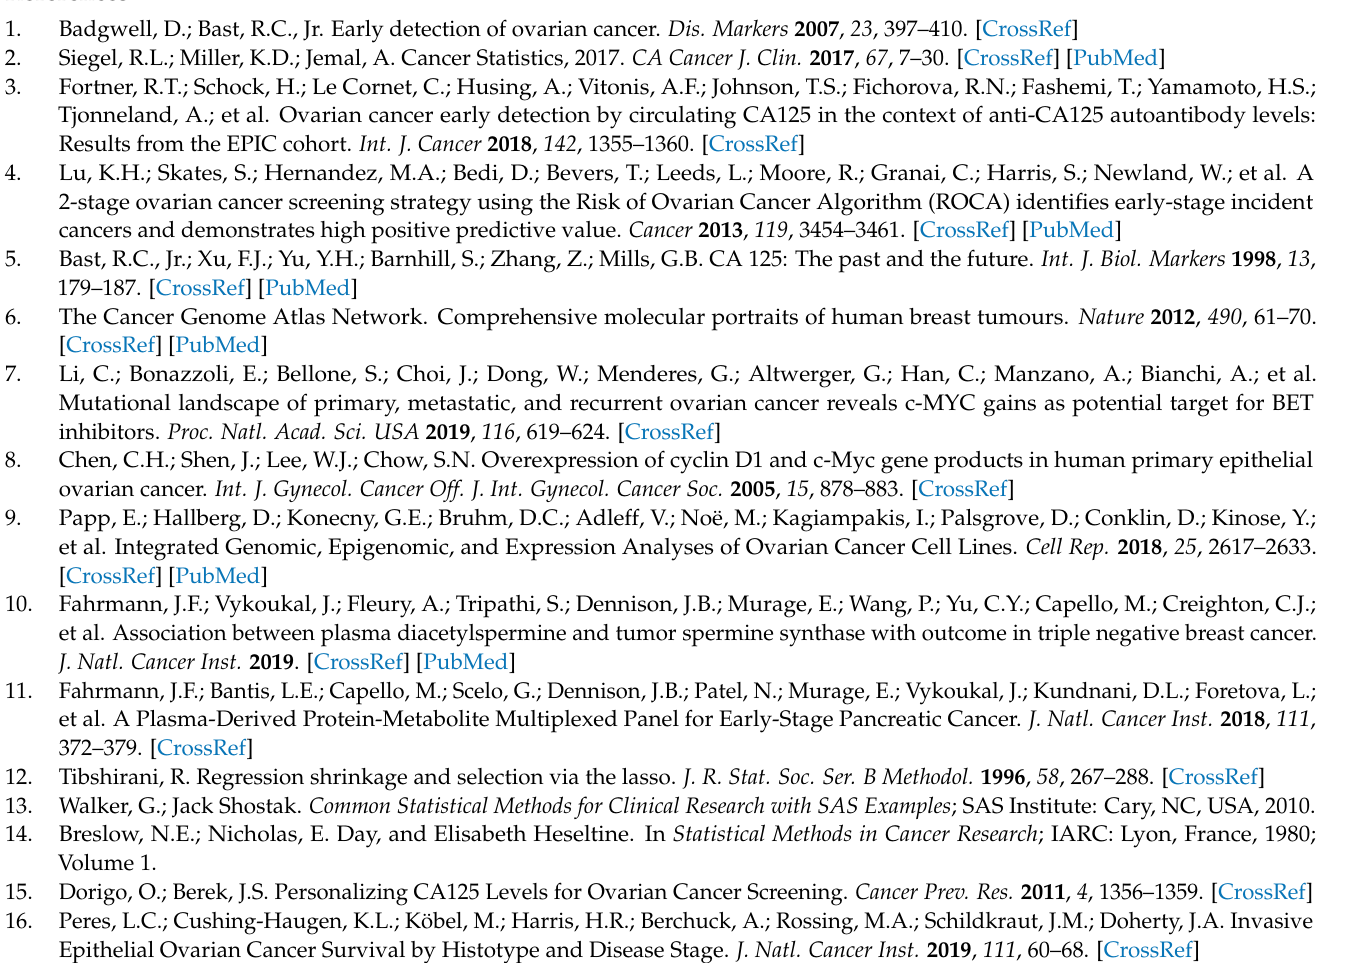
Figure A4. Scatter plot of depicting 3-marker panel scores (Y-axis) and CA125 values (X-axis) in CA125 ‘negative’ (defined as ≤ 35 U/mL) subjects in the Validation Set. Dashed lines represent 100% specificity cutoff.